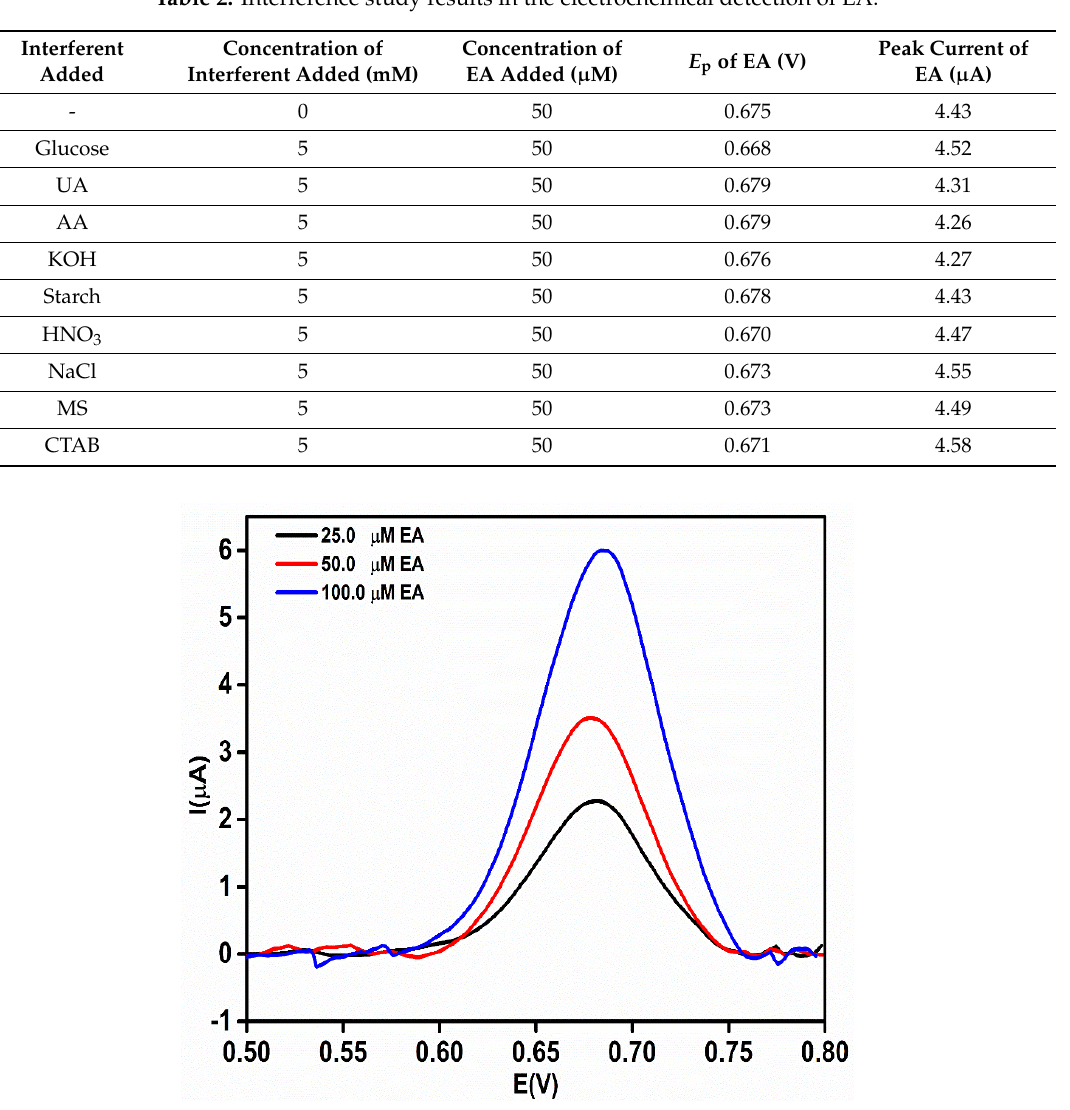
Figure 10. Differential pulse voltammetric (DPV) response of etidronate tablets at different Figure 10. Di ff erential pulse voltammetric (DPV) response of etidronate tablets at di ff erent concentrations (25.0, 50.0, and 100.0 μM) in 0.1 M NaOH. concentrations (25.0, 50.0, and 100.0 µ M) in 0.1 M